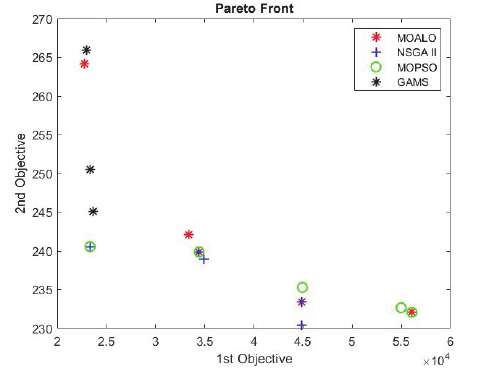
Fig. 12 . Comparison of efficient solutions to solving a small sample problem using the solution methods